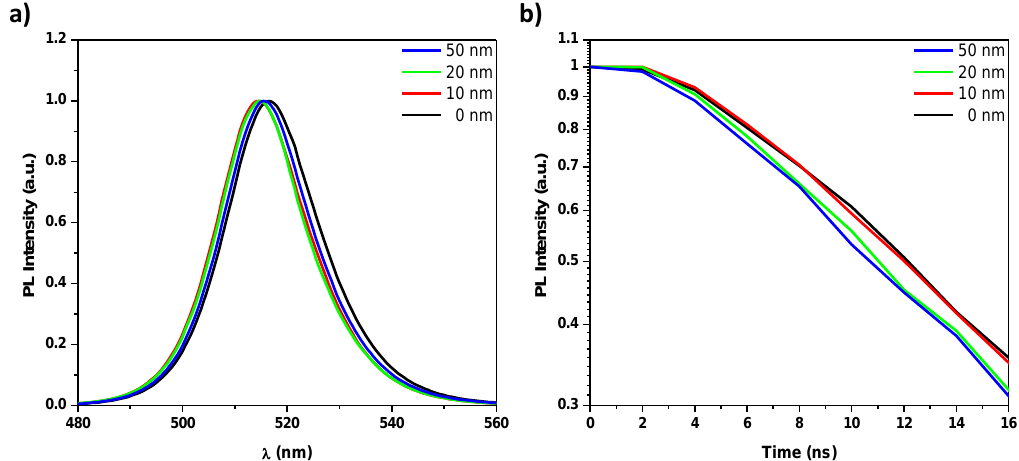
Figure 4. ( a ) PL spectra (normalized) and ( b ) the transient PL decay profiles of the pure PQDs CsPbBr 3 and CsPbBr 3 PQDs/c-TiO 2 films of 0, 10, 20, and 50 nm c-TiO 2 thickness respectively.